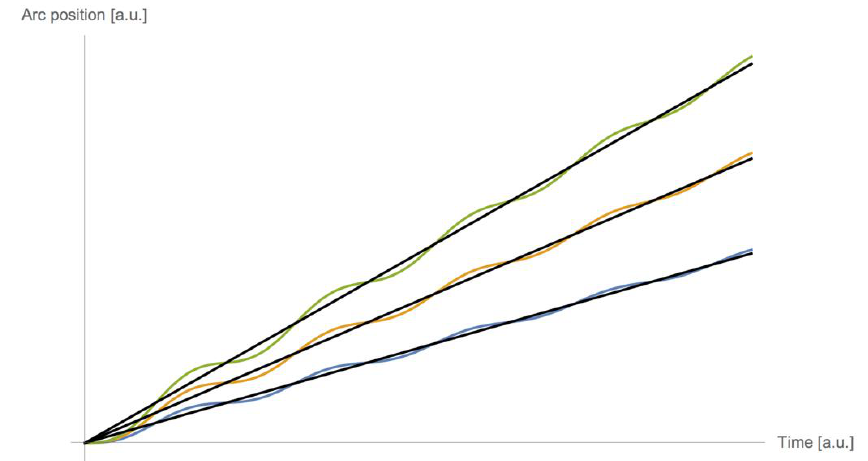
Figure 6. Transverse arc positions for different voltages ( V green = 2 V blue , V orange = 1.5 V blue ). The linear approximation for each linear approximation is shown in black.